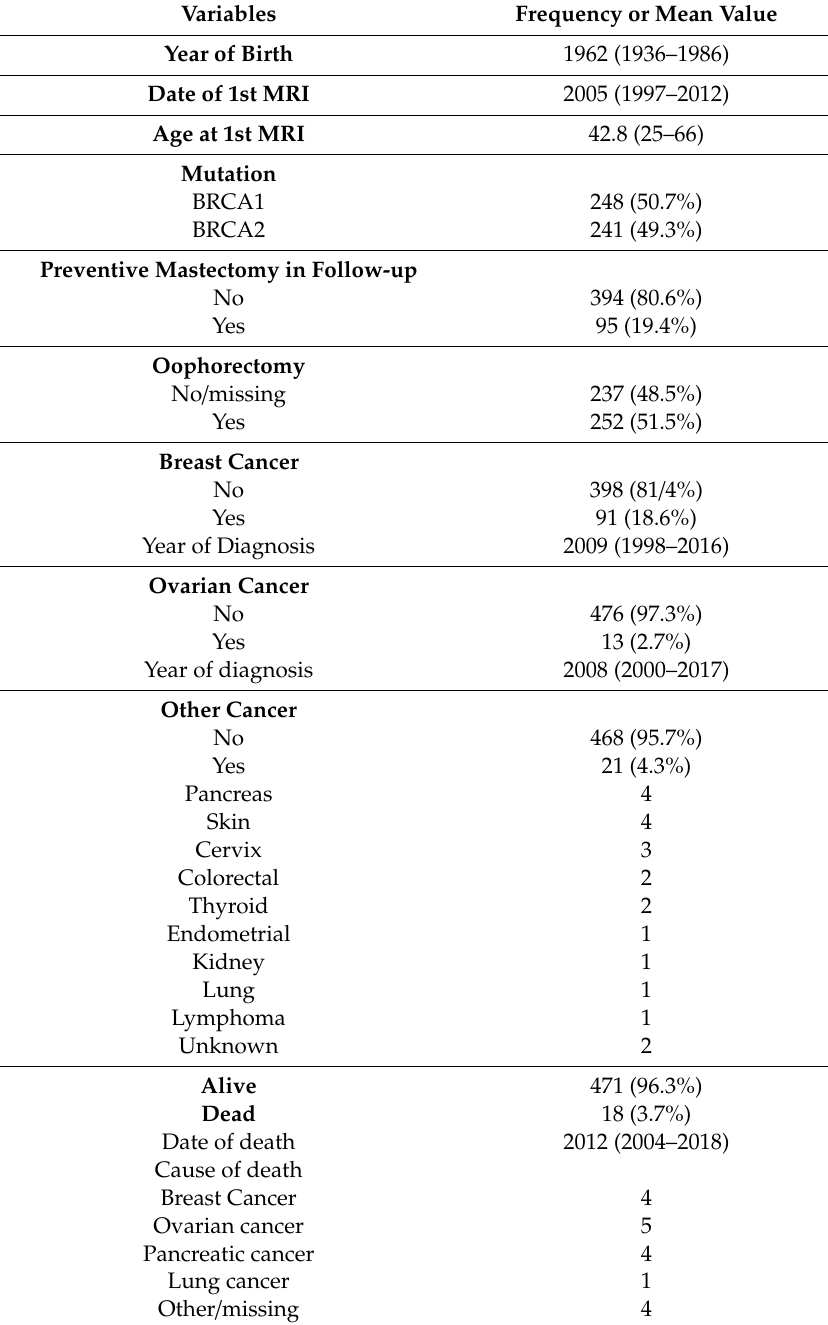
Table 1. Characteristics of the 489